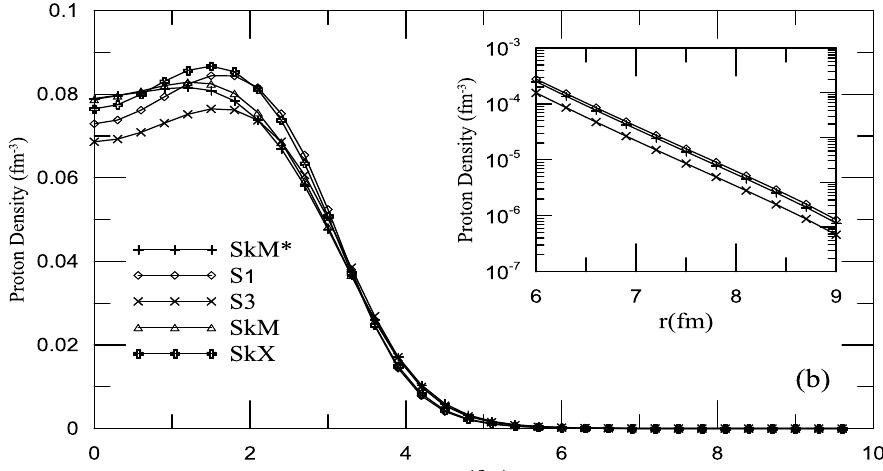
Fig. 1: Density curves of 28 Si as functions of radii calculated by different Skyrme parameterizations; (b) proton density.